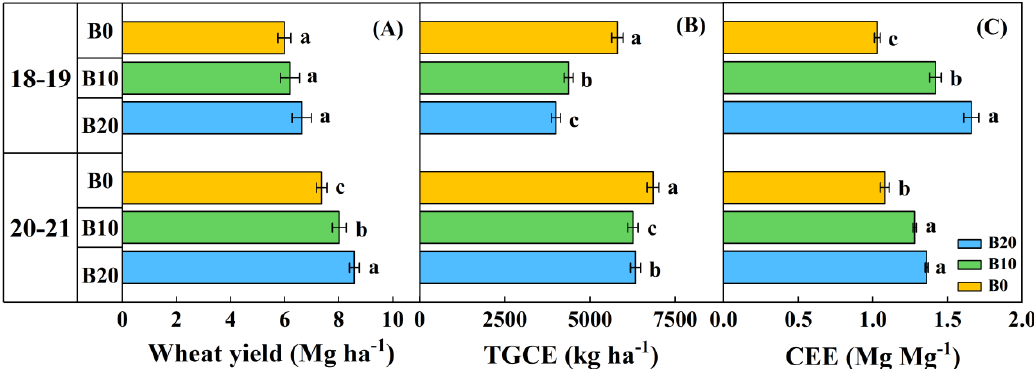
Figure 9. Wheat yield ( A ), total gaseous carbon emissions ( B ), and carbon emission efficiency ( C ) under different amounts of added biochar in 2018–2019 and 2020–2021. Note: TGCE represents total gaseous carbon emissions and CEE represents carbon emission efficiency. Values represent means ± standard errors and different lowercase letters indicate significant differences between treatments (Duncan’s test, p < 0.05).